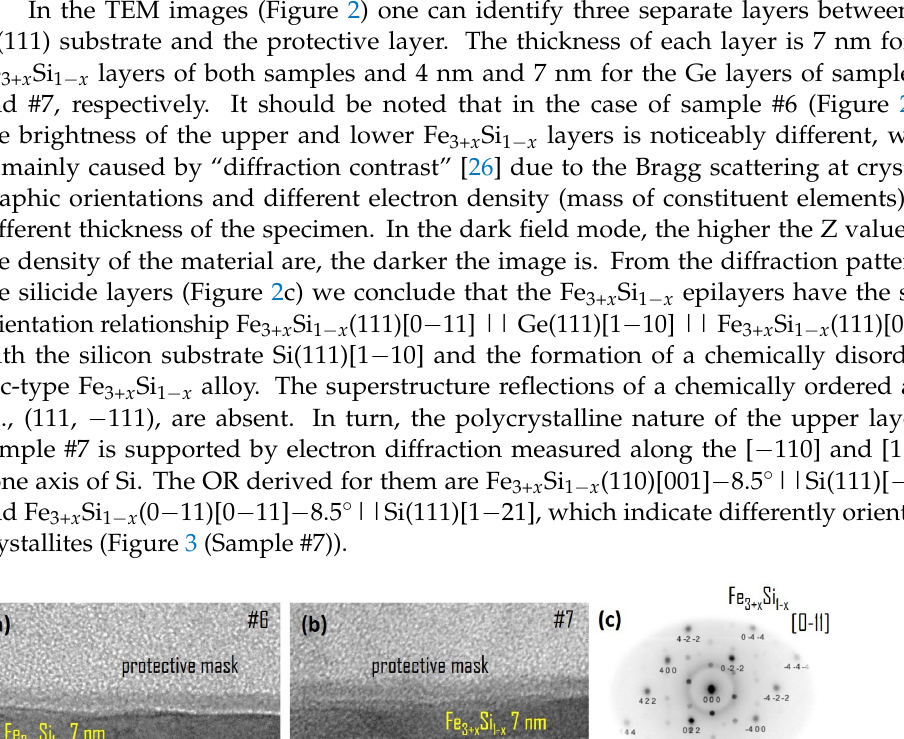
Figure 3. TEM electron diffraction pattern of cross-section of Fe 3+ x Si 1 − x /Ge/ Fe 3+ x Si 1 − x /Si(111) samples #6 and #7 along different projections (zone axes). The angles of reciprocal lattice vectors are given for each phase . We also analysed the epitaxial stress in the epilayer and in the crystallites of the pol- ycrystalline layer of the Fe-Si alloy. Changing the chemical composition within the tri- layers based on ferromagnetic Fe x (Si 1 − y Ge y ) alloys can be used to tune the epitaxial stress and thereby the electronic structure and, as a result, the functional properties of the ma- terial [27–29]. The lattice distortions δ a,b,c and δ α , β , γ can be regarded as additives to a , b , c and α , β , γ parameters and in the most cases result in the change of crystal symmetry [30]. By meas- uring interplanar distances with the X-ray diffraction (XRD) method or TEM in principle, one can determine the lattice distortions solving a given system of equations relating the interplanar distances and the lattice parameters [30]. Except for interplanar distance, TEM